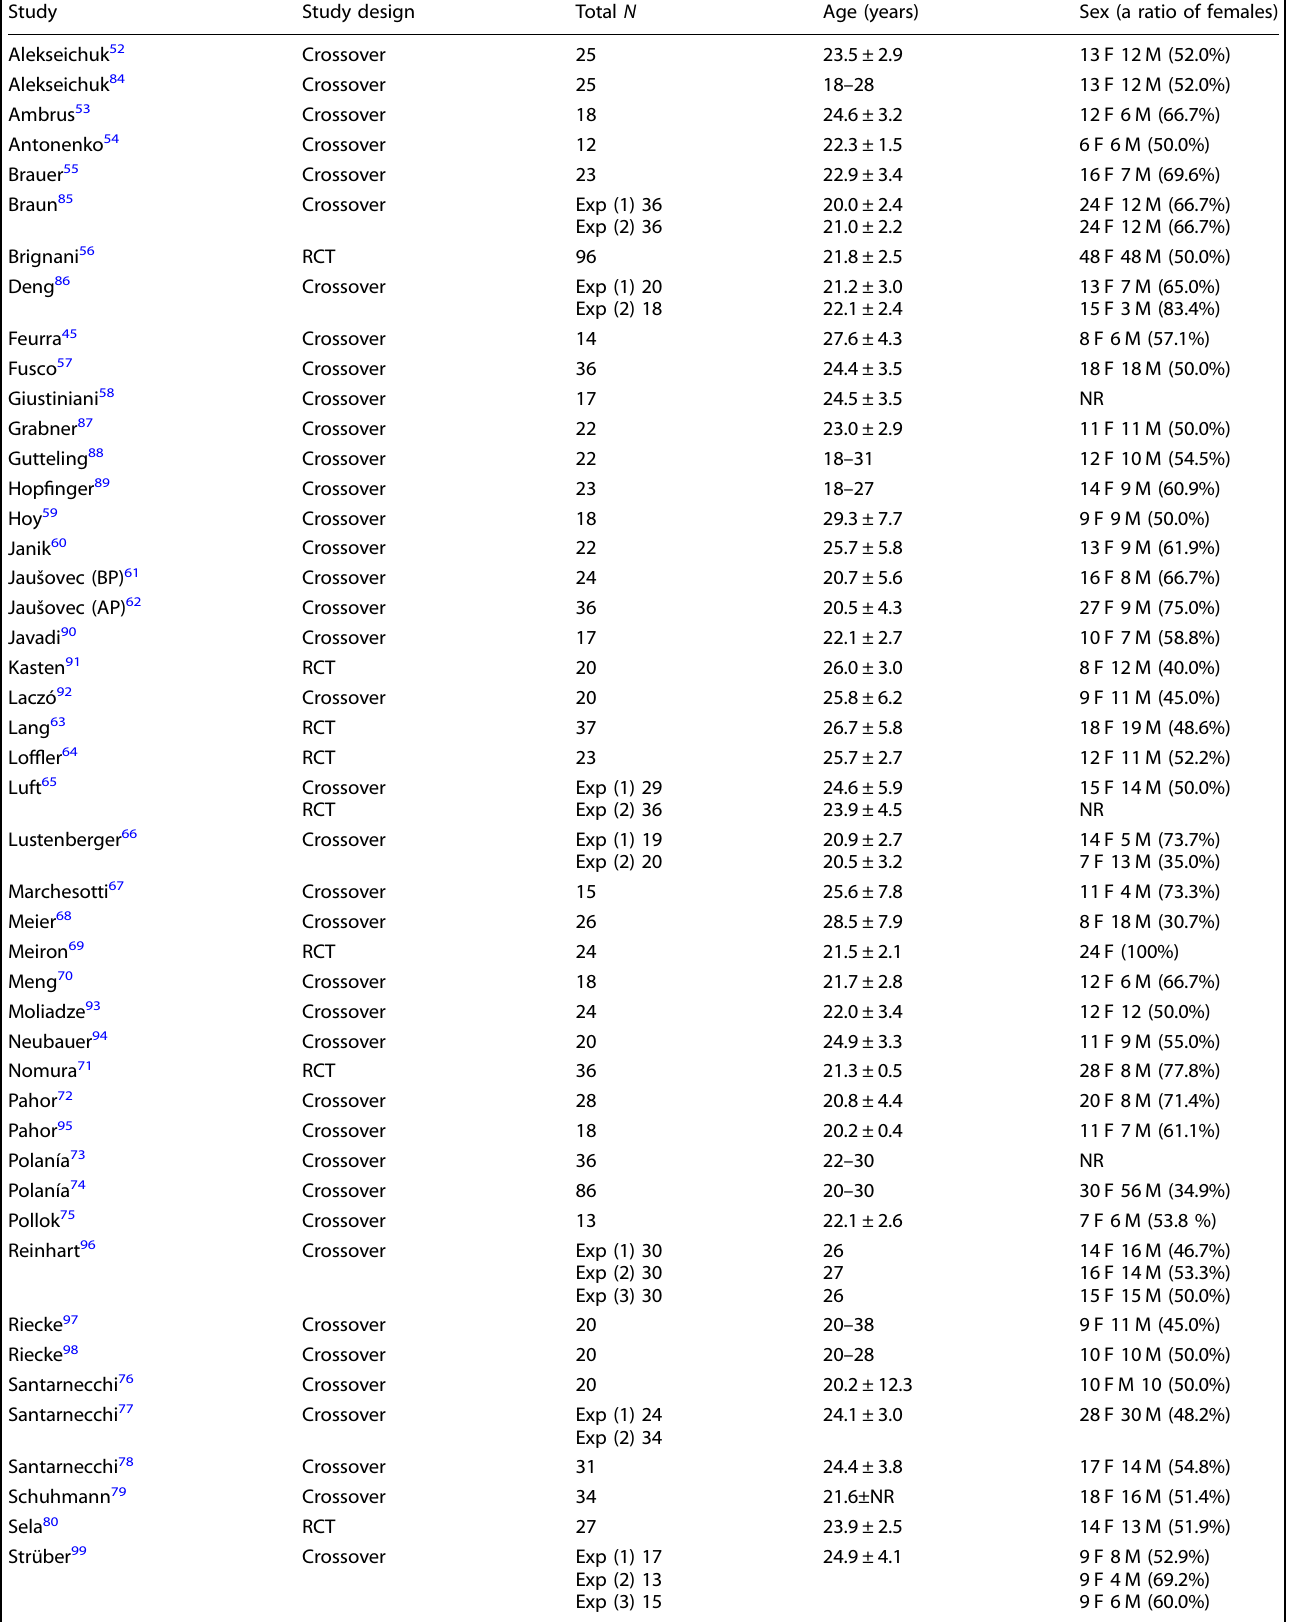
Table 1. Demographic information for